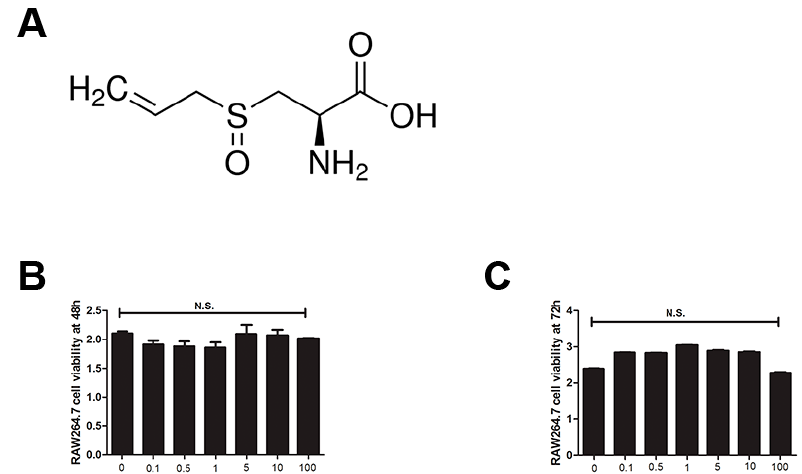
Figure 1. Alliin had no cytotoxicity during RANKL-induced osteoclastogenesis. ( A ) The chemical formula of alliin; ( B ) CCK-8 analysis of cell viability of RAW264.7 cells treated with various concentrations of alliin for 48 h; and ( C ) CCK-8 analysis of cell viability of RAW264.7 cells treated with various concentrations of alliin for 72 h. Data in the figures represent the mean ± SD. N.S. represents the difference was not statistically significant. It was based on one way ANOVA.